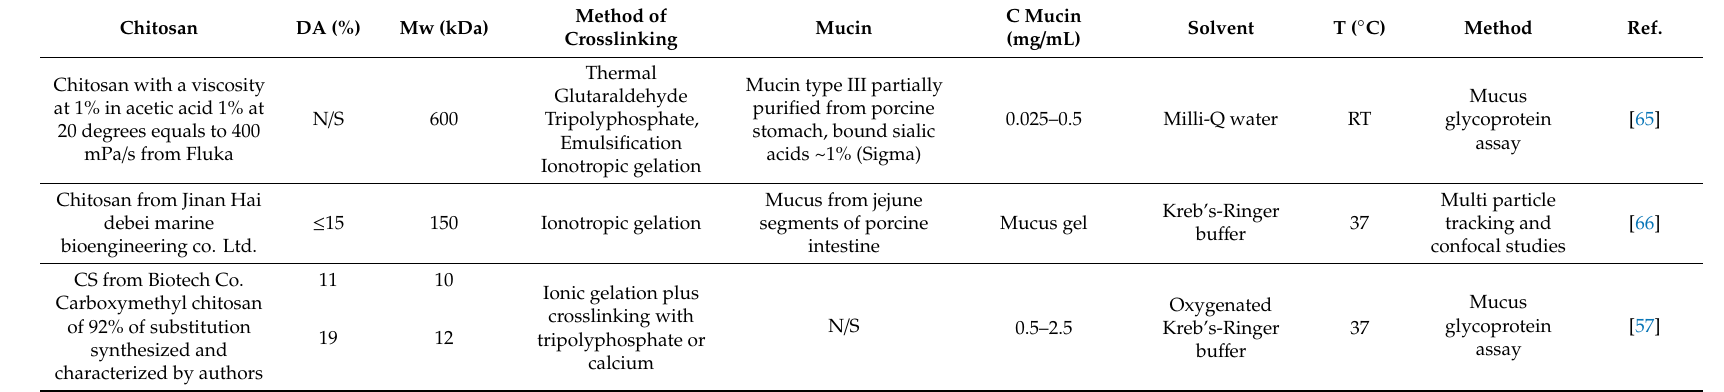
Table 3. Chitosan (CS) nanoparticles